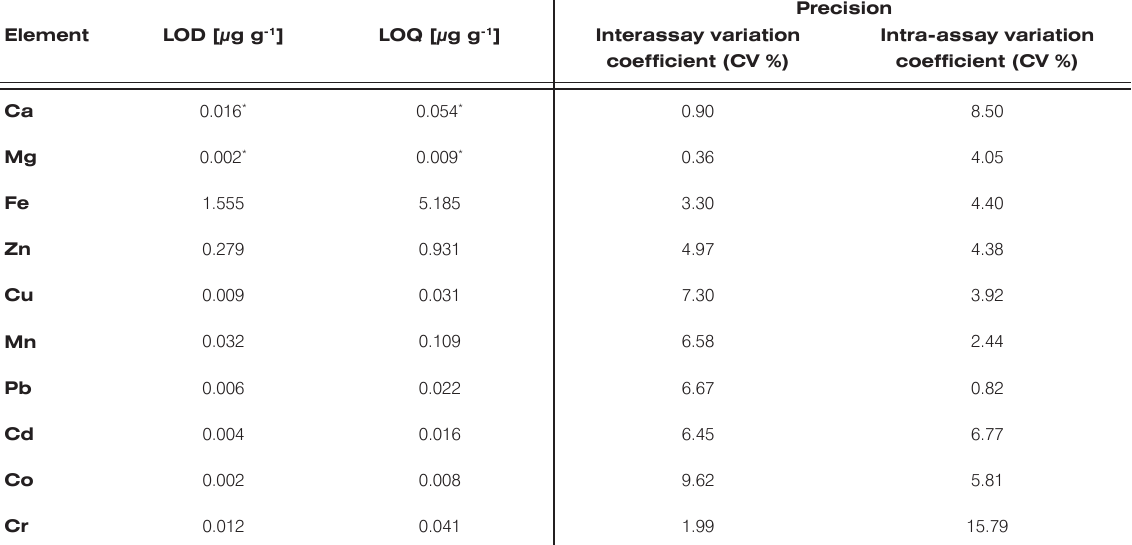
Table 3. Validation parameters of the analytical